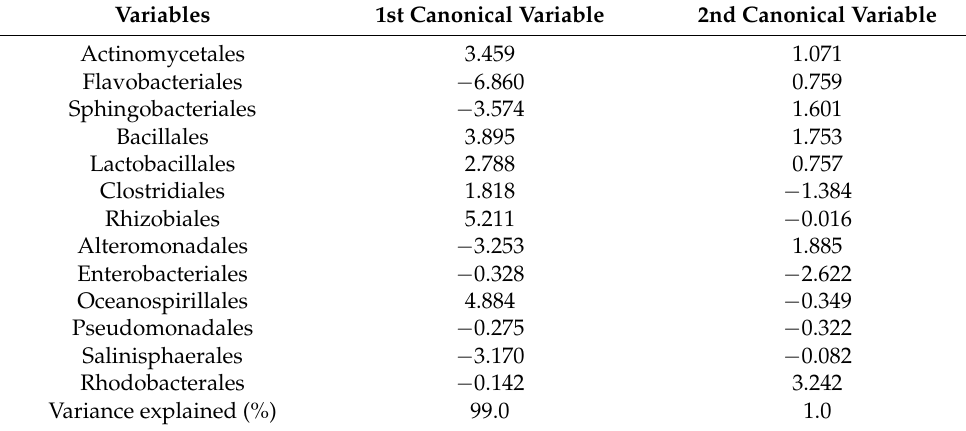
Table 4. Standardized canonical discriminant function coefficients.